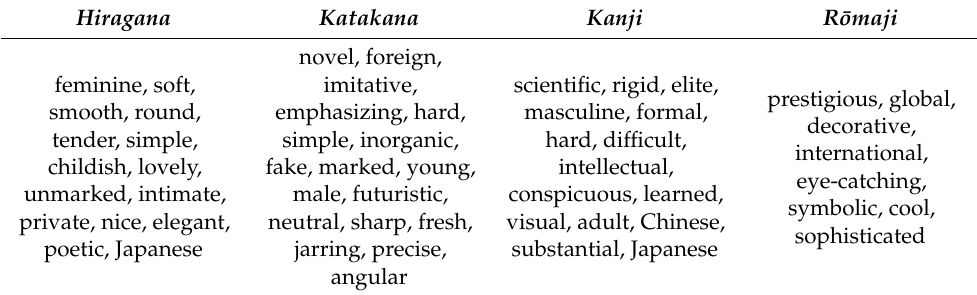
Table 1. Common Associations Ascribed to Japanese Scripts (Robertson